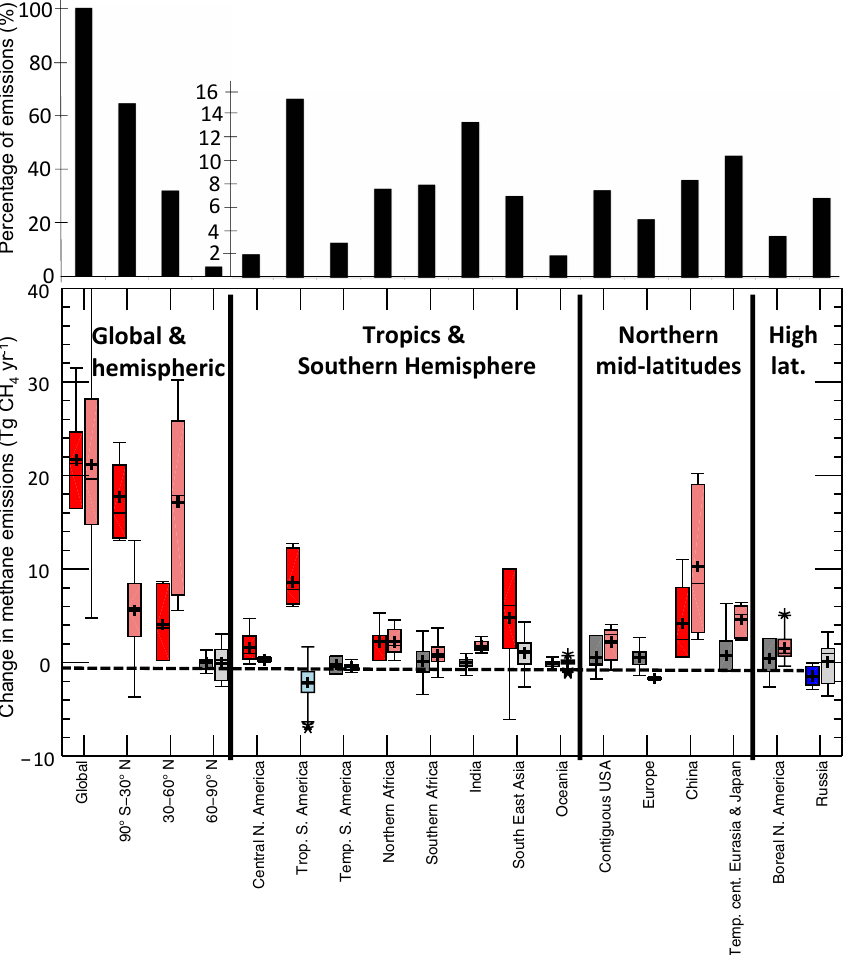
Figure 4. Top: contribution to the global methane emissions by region (in %, based on the mean top-down estimates over 2003–2012 from Saunois et al., 2016). Bottom: changes in methane emissions over 2002–2006 and 2008–2012 at global, hemispheric, and regional scales in TgCH 4 yr − 1 . Red box plots indicate a significant positive contribution to emission changes (first and third quartiles above zero), blue box plots indicate a significant negative contribution to emission changes (first and third quartiles below zero), and grey box plots indicate not-significant emission changes. Dark coloured boxes are for top-down (five long inversions) and light coloured for bottom-up approaches (see text for details). The median is indicated inside each box plot (see Sect. 2). Mean values, reported in the text, are represented with “ + ” symbols. Outliers are represented with stars. (Note: the bottom-up approaches that provide country estimates – and not maps, USEPA and FAOSTAT – have not been processed to provide hemispheric values. As a result the ensemble used for the three hemispheric regions differs from the ensemble used for the global and regional